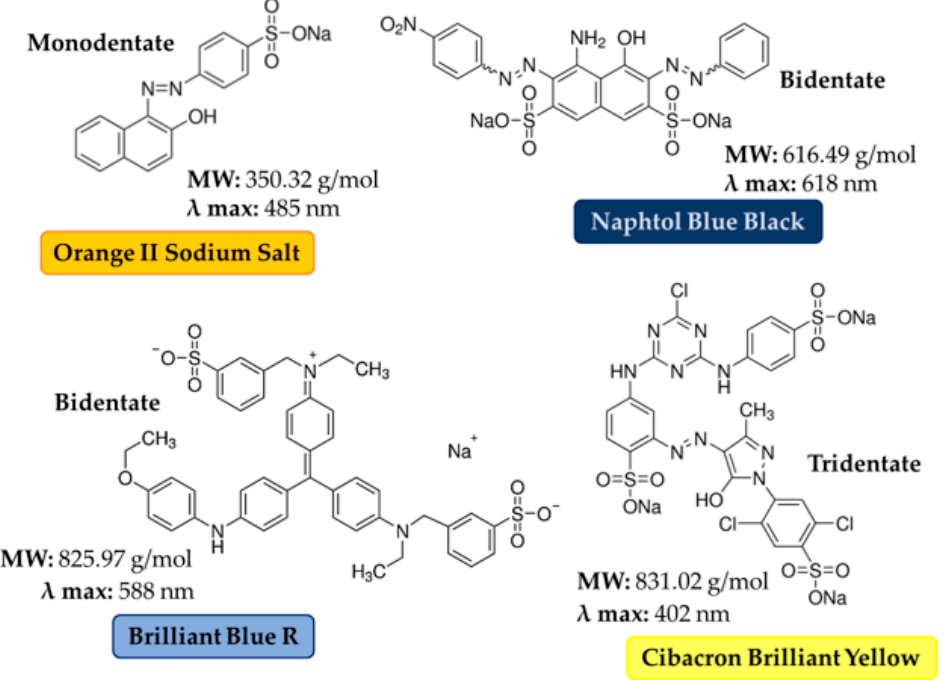
Figure 1. Chemical structure and properties of the dyes used for the sorption tests.